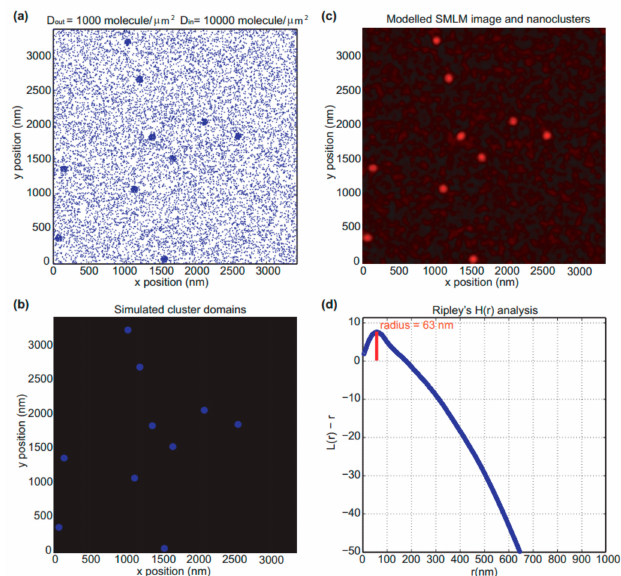
Figure1. ( a )Spatialpointpatternswith10clusterspresent, proteindensityforoutsideandinsideclusters was D out = 1000 molecules / µ m 2 and D in = 10,000 molecules / µ m 2 , respectively. ( b ) Disk-shaped = 50nm. ( c ) Simulated image produced by cluster domains in ( a ); the radius of the cluster is R set cluster Gaussian convolution of points in ( a ) using 30 nm resolution. ( d ) Peak analysis results, the peak value of H is r = 63